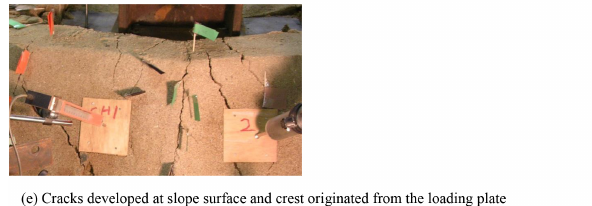
Figure 6. Failure process of the soil slope under increasing loading. the peak load, the applied load decreased with increasing jack displacement. From the displacements for the left and right LDTV at the upper and lower levels, it was clear that the displacements of the slope were basically symmetrical.